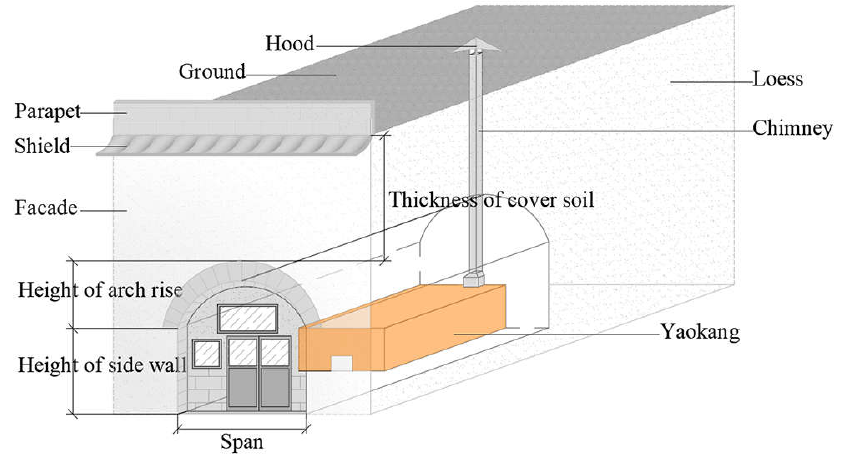
Figure 4. Structure diagram of the underground cave room.